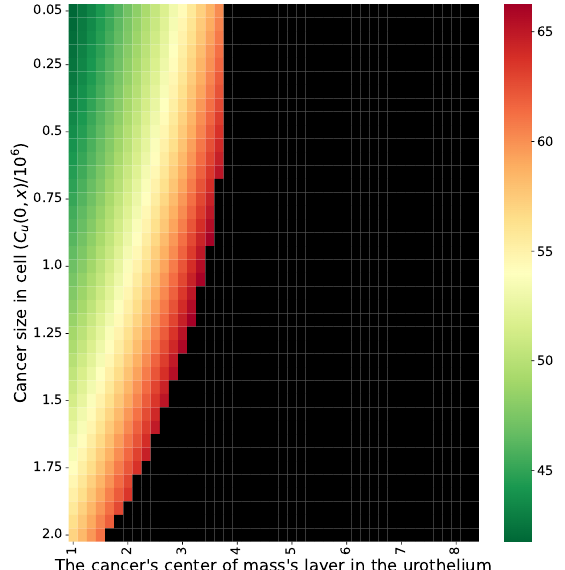
Figure 6. The average duration in days of successful and time-optimal treatment for n = 1000 reparations as a function of the initial uninfected cancer cell population size and the layer in which the cancer cell population’s center of mass is located. Black cells indicate that the GA failed to find a successful treatment protocol. The results are shown for the parameter values provided in Table